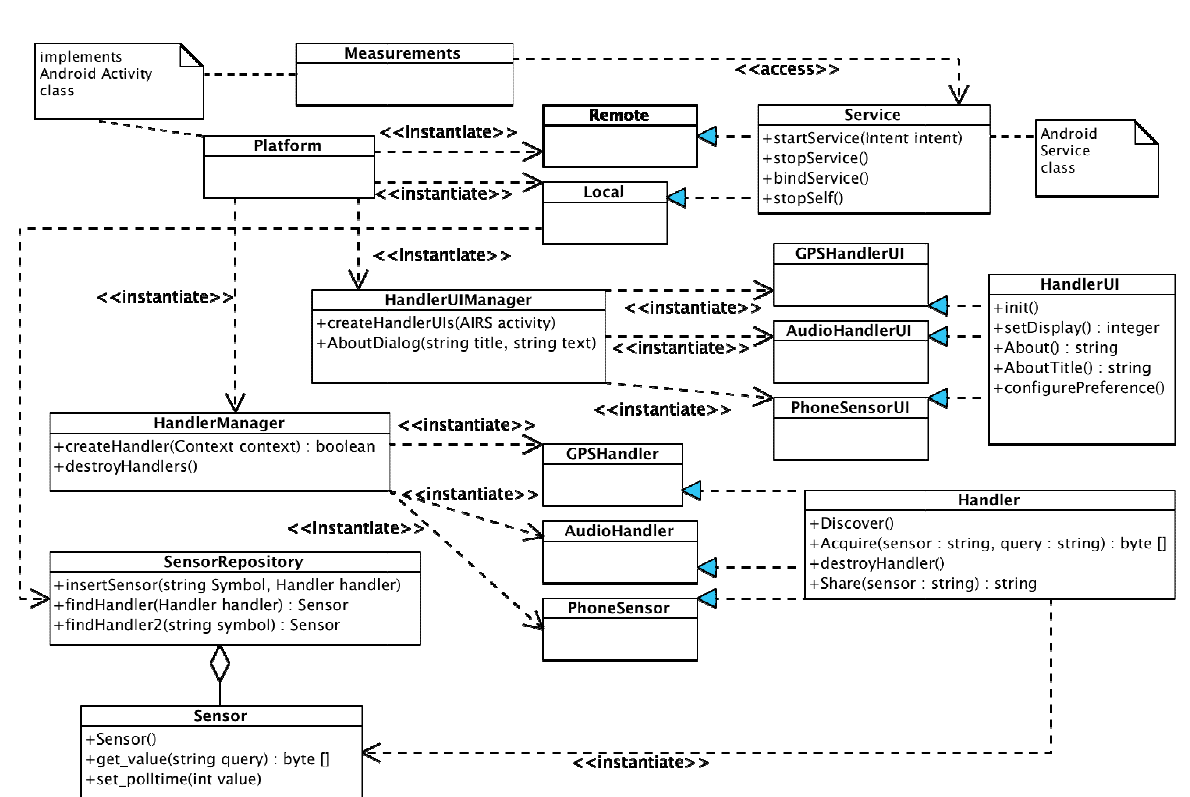
Figure 1 . AIRS implementation